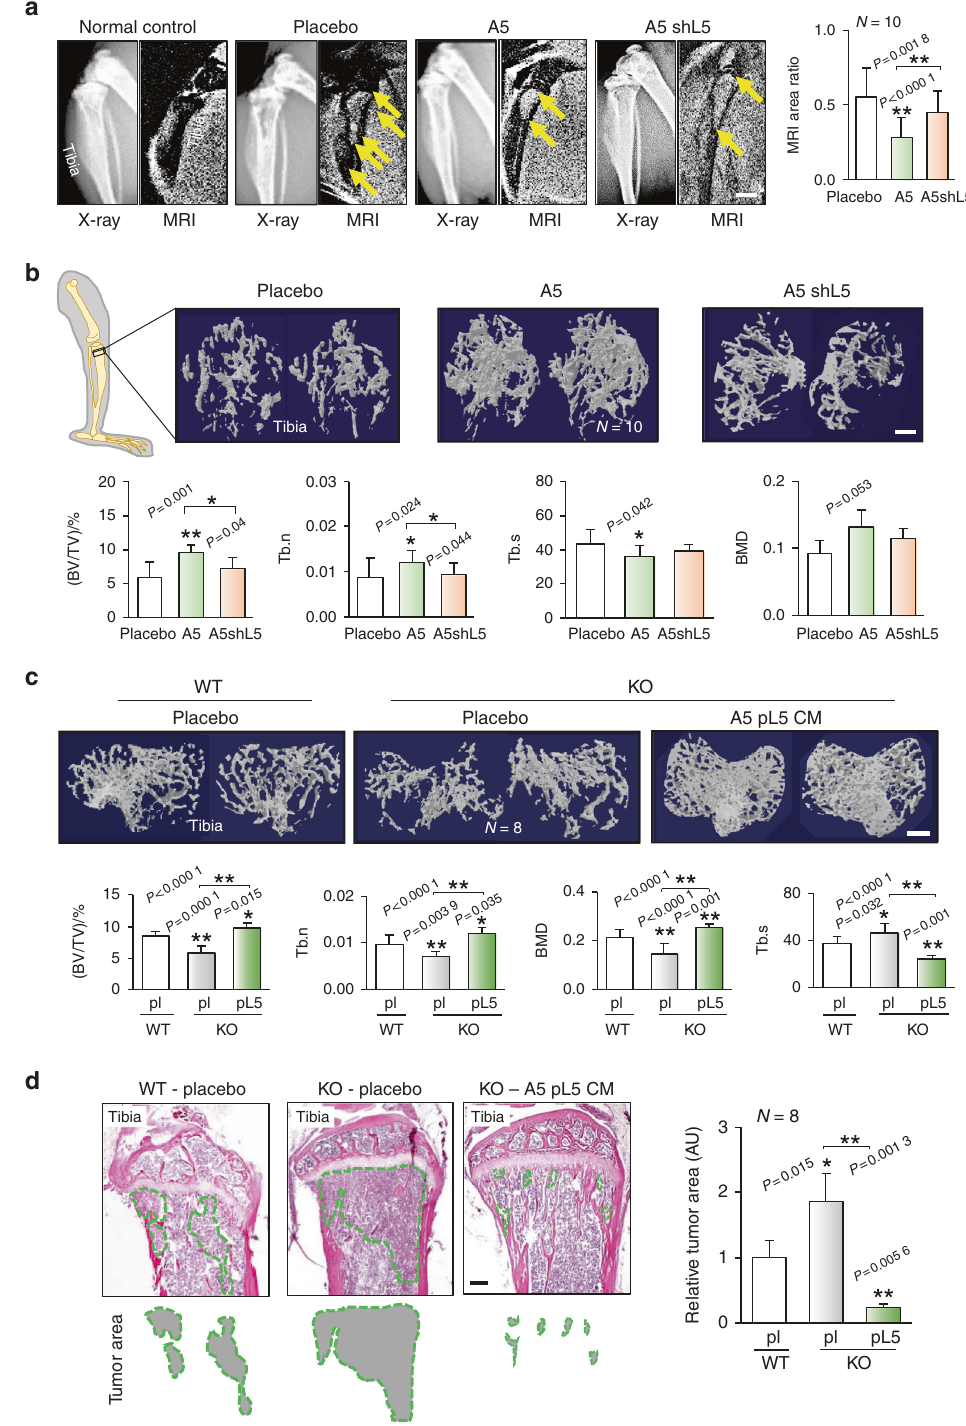
Fig. 4 Effects of coinjection of A5 osteocytes and tumor cells into the tibia in C57BL/6 mice. pl placebo, shL5 Lrp5 shRNA, pL5 Lrp5 plasmids, WT wild-type, KO Lrp5 conditional knockout, and CM conditioned medium. The single and double asterisks indicate P < 0.05 and P < 0.01, respectively. a Representative X-ray and MR images of the tibia in the normal control (healthy group), placebo, A5 cell-coinjected, and Lrp5 shRNA-treated A5 groups. The yellow arrow in the MR image indicates a tumor-induced lesion in the tibia. The MR image-based percentage area of the tumor-induced lesion is shown. Scale bar: 1 mm. b Representative μ CT images of the proximal tibia in the placebo, A5 cell- coinjected, and Lrp5 shRNA-treated A5 groups. μ CT-based parameters are shown: BV/TV bone volume normalized by total volume, Tb.N trabecular number, Tb.S trabecular separation, and BMD bone mineral density. Scale bar: 500 μ m. c Representative μ CT images of the proximal tibia, showing the severe bone loss caused by tumor growth in Lrp5 KO mice and its rescue by Lrp5-overexpressing osteocyte-derived CM. Scale bar: 500 μ m. d H&E-stained proximal tibiae of mice with Lrp5 KO. Lrp5-overexpressing osteocyte-derived CM signi fi cantly reduced tumor growth. The green-shaded area shows the tumor-invaded region. Of note, tumor cells typically appeared hyperchromatic with an increased nucleoplasmic ratio. Scale bar: 200 μ